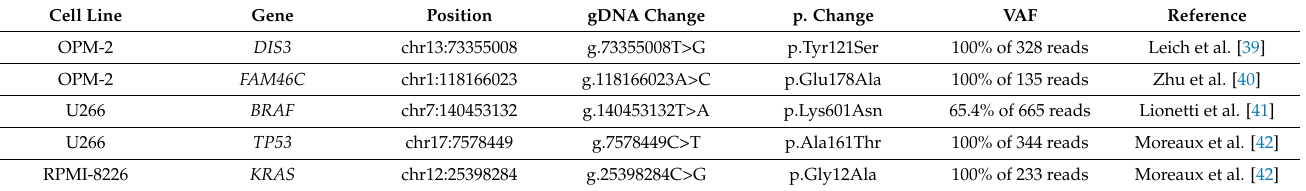
Table 2. Identification of previously described genetic variants in HMCLs. The detectability of previously described genetic variants in HMCLs was used as a positive control for our targeted gene sequencing technique. For each variant, its genomic position together with gDNA and protein change are indicated. Abbreviations used: VAF = variant allele